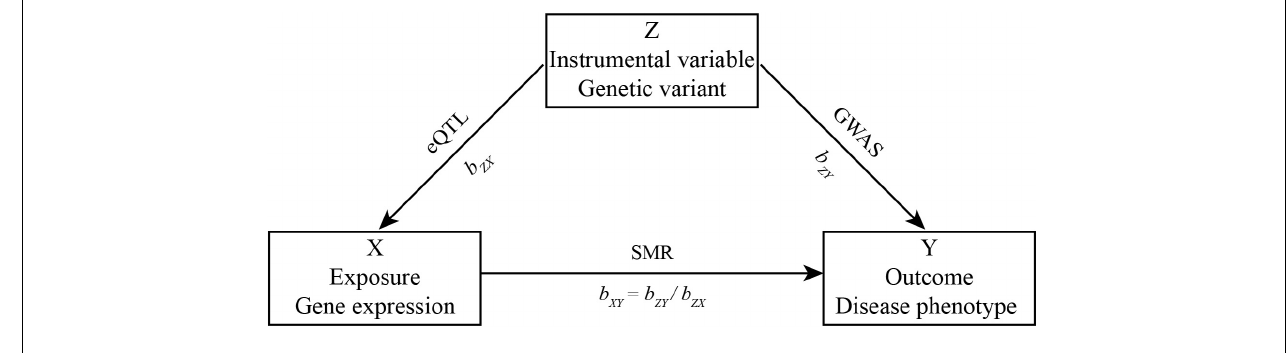
FIGURE 1 | Workflow.